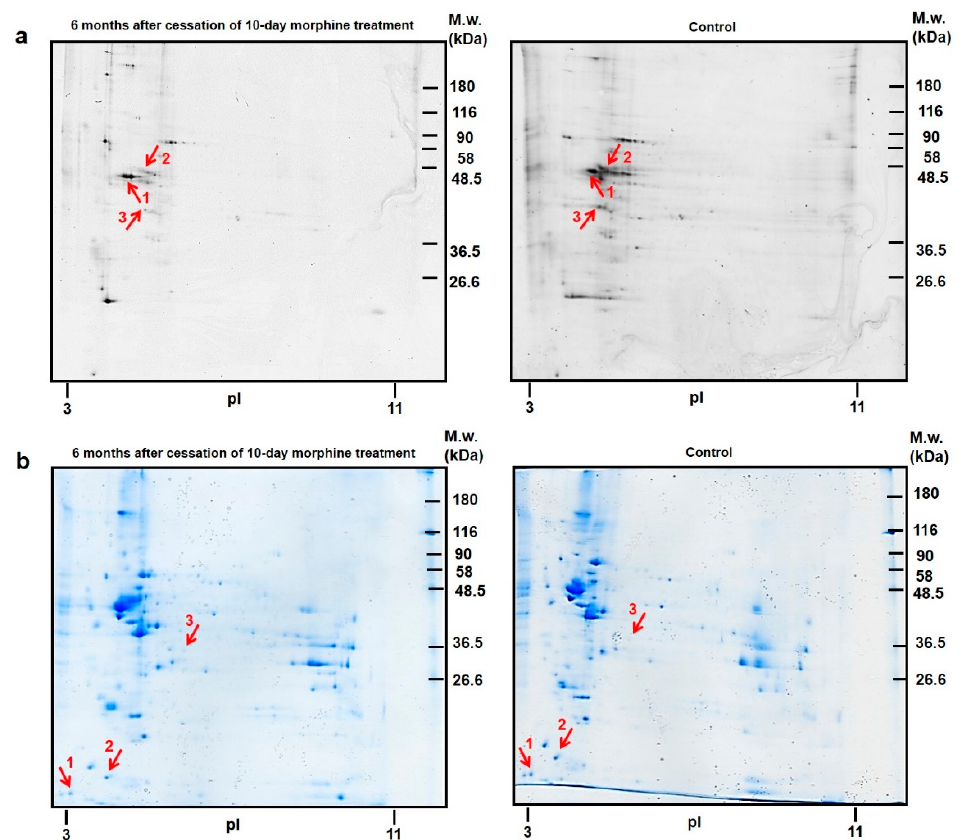
Figure 4. Representative 2D gel maps of phosphorylated proteins ( a ) and total protein profiles ( b ) in the rat forebrain cortex isolated from animals after 6 months of morphine withdrawal. Red arrows and numbers show the significantly altered protein spots.